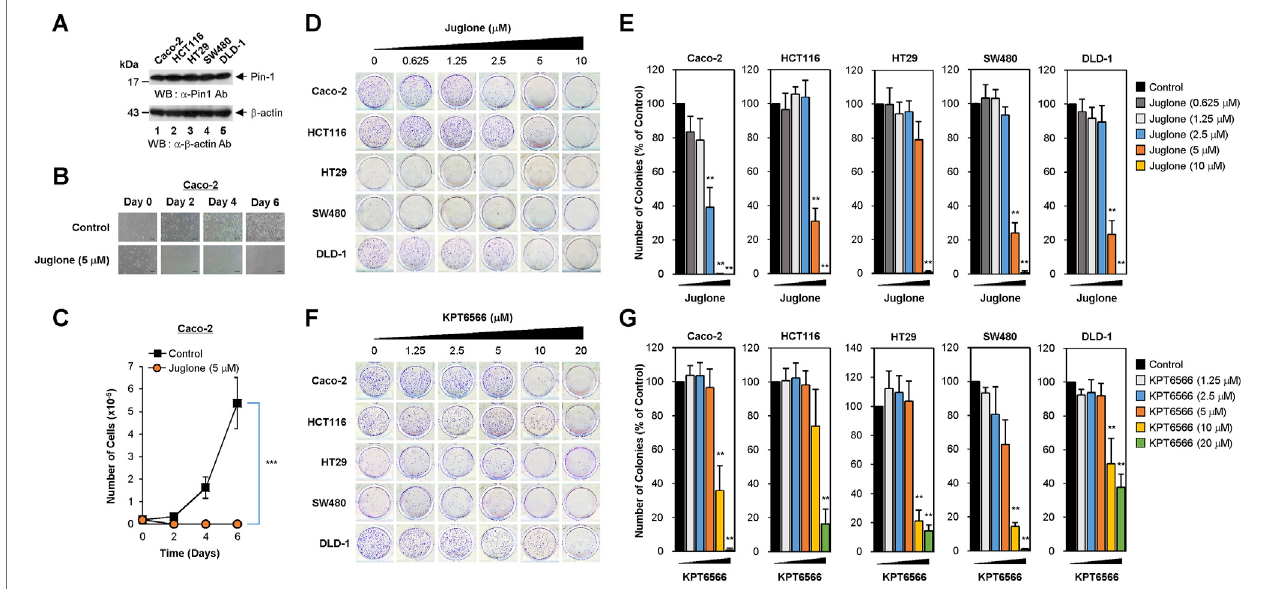
FIGURE 1 | Dose-dependent inhibition of human colorectal cancer cell colony formation by Juglone or KPT6566. (A) Expression of Pin1 by colorectal cancer cell lines. Caco-2 (lane 1), HCT116 (lane 2), HT29 (lane 3), SW480 (lane 4), or DLD-1 (lane 5) human colorectal cancer cells were harvested and cell lysates prepared. Total proteinwasfractionatedbySDS-PAGE(15%gelsforanti-Pin1and 12%gelsforanti- β -actinblots),transferredtoaPVDFmembrane,and immunoblottedwithanti-Pin1 (upperpanel)or β -actin(bottompanel)antibodiesasindicated.Thepositionoftheprestainedproteinmolecularweightmarker(NewEnglandBiolabs)isindicatedto the left of the gel (kDa). Similar results were obtained from three independent experiments. (B) Morphology of Caco-2 cells exposed to Juglone. Caco-2 cells (2 × 10 4 ) were plated into 12-well culture plates and incubated with Juglone (5 μ M). Cells were monitored at 2 days intervals for 6 days under an inverted phase-contrast microscope (IX71; Olympus). Scale bars, 100 μ m. Similar results were obtained from three independent experiments. (C) Inhibition of Caco-2 cell growth by Juglone. Caco-2 cells were seeded at 2 × 10 4 cells/well and grown in EMEM supplemented with or without 5 μ M Juglone. Cells were counted at 2 days intervals for a total of 6 daysusingahemocytometer.Valuesareexpressedasthemean±S.D.Similarresultswereobtainedfromthreeindependentexperiments.Statisticalsigni fi cancewas determined using an unpaired Student ’ s t-test. *** p < 0.001, versus control group. (D) Suppression of colony formation by Juglone. Caco-2 (top panels), HCT116 (second panels), HT29 (third panels), SW480 (fourth panels), and DLD-1 cells (bottom panels) were seeded at a density of 2.5 × 10 3 per well and cultured in medium containing 0, 0.625, 1.25, 2.5, 5, or 10 μ M Juglone. Colony formation assays were performed 5 days later, and colonies were visualized by staining with 0.05% (w/v) of Crystal Violet. Representative images are shown. Three independent experiments yielded similar results. (E) Quanti fi cation of the reduction in Caco-2 ( fi rst graph), HCT116 (second graph), HT29 (third graph), SW480 (fourth graph), and DLD-1 cells ( fi fth graph) colony formation after Juglone treatment. Colonies were counted after Crystal Violet staining, and the number of colonies formed was compared with that in the untreated group (0 μ M Juglone). Similar results were obtained from three independent experiments. The value in the control group was normalized to 100. Values represent the mean ± S.D. Statistical signi fi cance was determined using an unpaired Student ’ s t-test. ** p < 0.01, versus control cells. (F) Inhibition of colony formation by KPT6566. The same human colorectal cancer cells were seeded at a density of 2.5 × 10 3 per well and cultured in medium containing 0, 1.25, 2.5, 5, 10, or 20 μ M KPT6566. Colony formation assays were performed 5 days later, and colonies were visualized by staining with 0.05% (w/v) Crystal Violet. Representative images are shown. Similar results were obtained in three independent experiments. (G) Relative colony number after KPT6566 treatment. To quantify the reduction in colorectal cancer cell colony formation after KPT6566 treatment, Caco-2, HCT116, HT29, SW480, and DLD-1 cells were visualized by staining with 0.05% (w/v) Crystal Violet. Independent experiments were repeated at least three times, and triplicate wells(atleast)wereused.Valuesareexpressed asthemean±S.D.,andstatisticalanalysiswasdoneusinganunpairedStudent ’ st-test.** p <